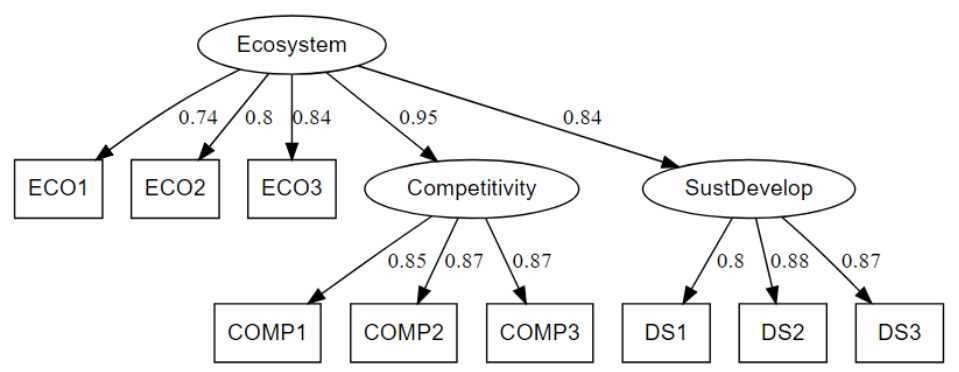
Figure 2. Structural model fitted with standardized regression coefficients. Constructs. SustDevelop: Sustainable Development, Competitivity: Competitiveness, Ecosystem: Entrepreneurial Ecosystem.